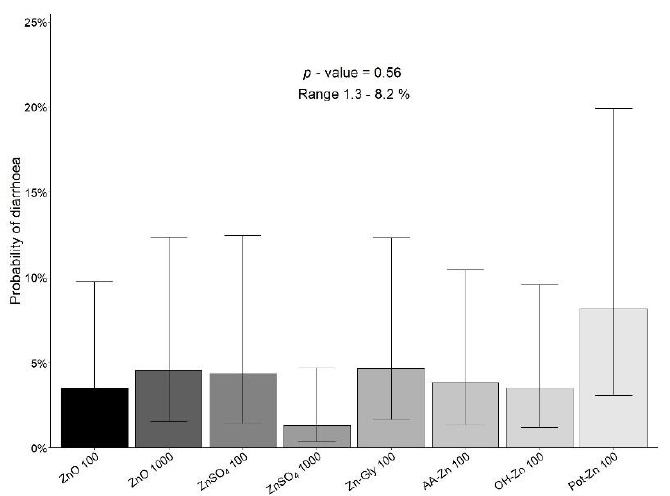
Figure 1. The probability of diarrhoea in pigs receiving different sources and levels of added Zn in their diet from d 0 – 21 post-weaning. n = 11 – 12/treatment.